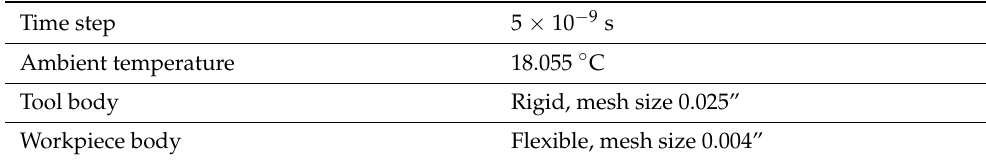
Figure 4. Initial Cutting Engagement—first engagement of cutting tool on the workpiece. Table 1. Simulation Parameters used in this